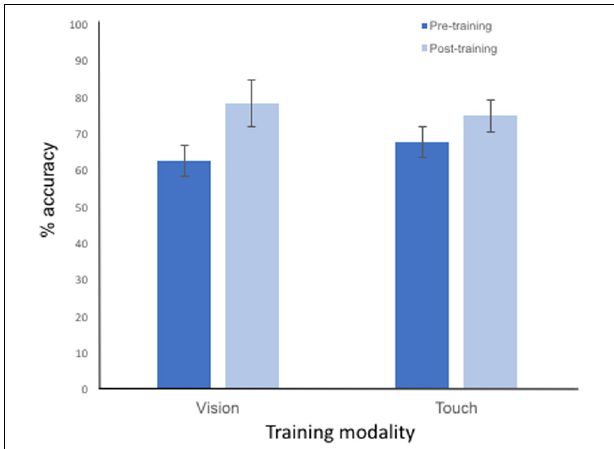
FIGURE 2 | Plot showing the mean accuracy performance to each categorisation task conducted pre-training and post-training. The categorisation task was conducted using vision only and performance is shown to stimuli previously trained in the visual (i.e., within modality) and tactile (i.e., cross-modal) modalities. Error bars represent ± 1